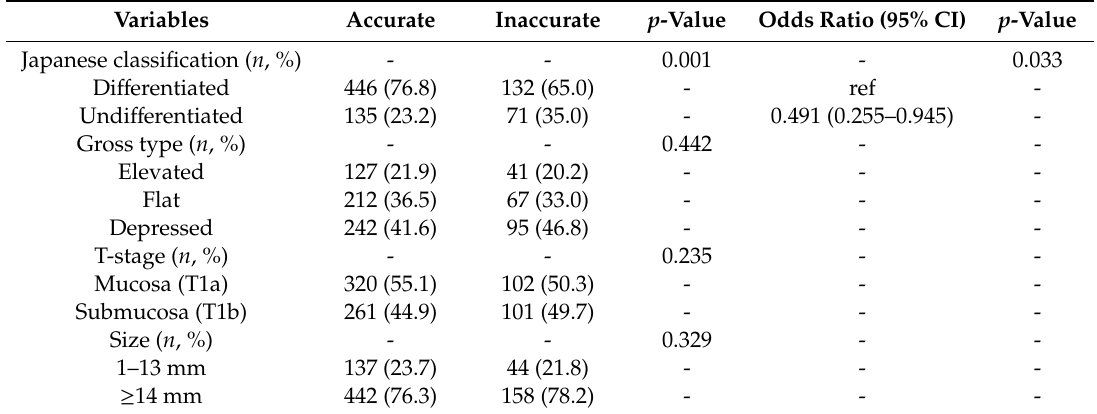
Table 3. Factors a ff ecting the accuracy of